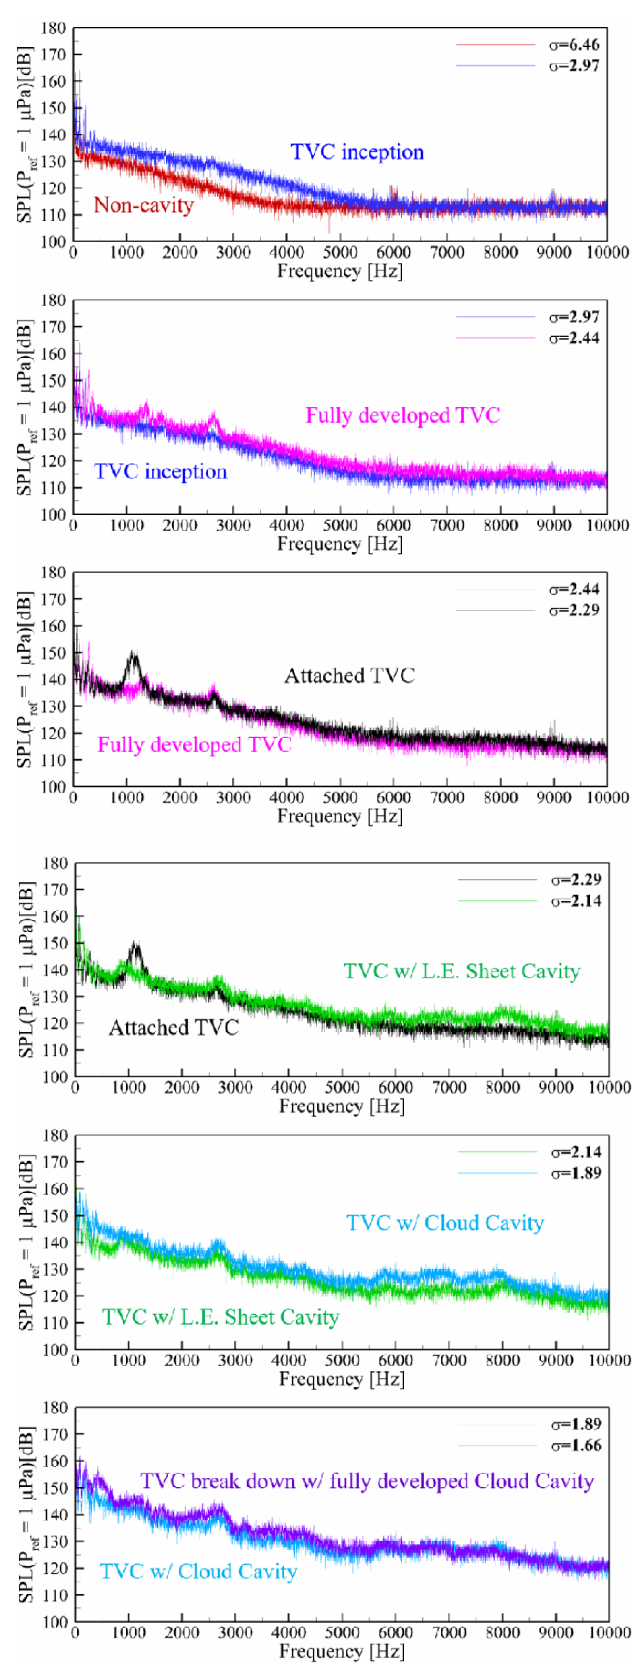
Figure 8. Induced noise characteristics of NACA 16-020 hydrofoil at α = 15 ◦